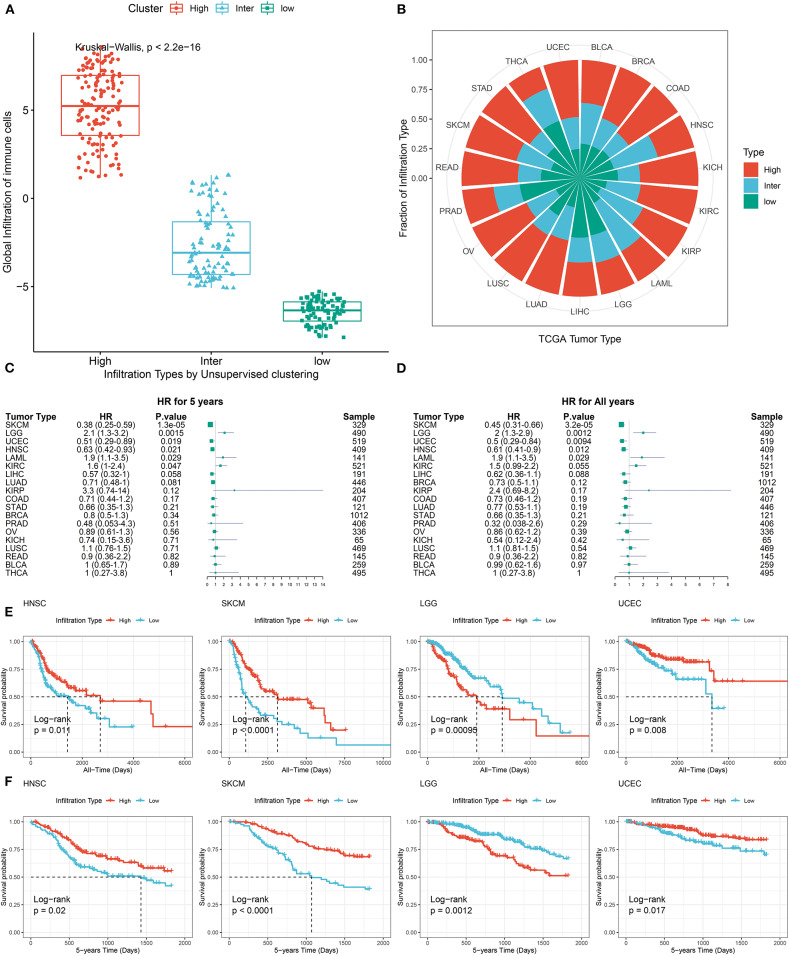
Pan-cancer prognostic role of identified TME subtypes. (A) The global infiltration characteristics of distant TME subtypes. (B) The proportion of TME subtypes in different cancer types. (C,D) Forest plot for the association between identified TME subtypes and overall survival time of patients. (E,F) All years or 5 years overall survival time of inflamed (High) and non-inflamed (Low) TME. Tumor types were represented by TCGA. Standard abbreviations: LAML, acute myeloid leukemia; BLCA, bladder urothelial carcinoma; LGG, brain lower grade glioma; BRCA, breast invasive carcinoma; COAD, colon adenocarcinoma; KICH, kidney chromophobe; KIRC, kidney renal clear cell carcinoma; KIRP, kidney renal papillary cell carcinoma; LIHC, liver hepatocellular carcinoma; LUAD, lung adenocarcinoma; LUSC, lung squamous cell carcinoma; OV, ovarian serous cystadenocarcinoma; PRAD, prostate adenocarcinoma; READ, rectum adenocarcinoma; SKCM, skin cutaneous melanoma; STAD, stomach adenocarcinoma; THCA, thyroid carcinoma; UCEC, uterine corpus endometrial carcinoma.